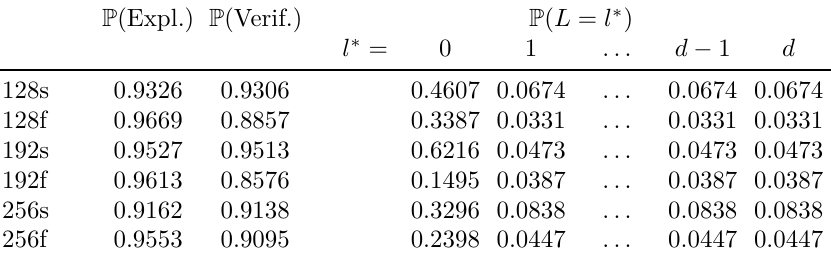
Table 4: Fault analysis results for all SPHINCS +